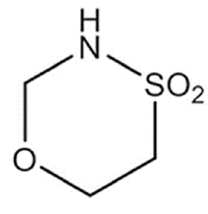
Figure 1. Structural formula of the novel anti-neoplastic agent GP-2250 (Tetrahydro-1,4,5-Oxathiazin-4,4-dioxid); reprinted with permission from [15].